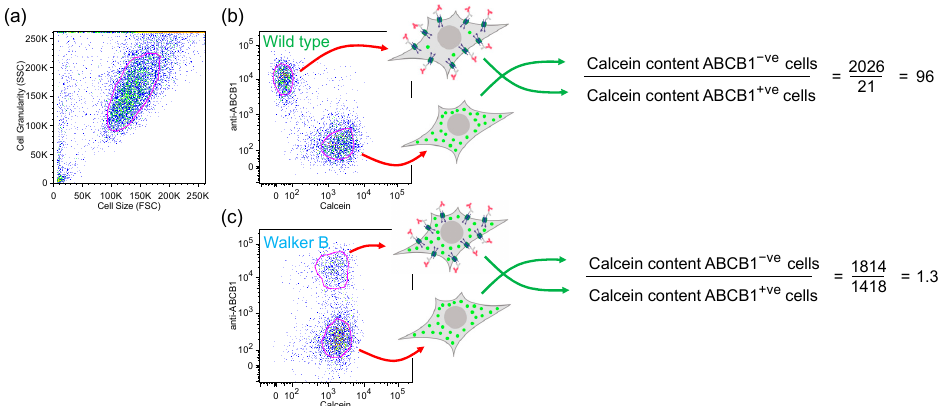
Figure 2. Measurement of functionality of ABCB1 for the transport of Calcein-AM by flow cytometry. ( a ) Dotplot showing the gating (autogated population circled in red) of HEK293T cells of normal size and granularity; ( b ) two-color dotplot of the gated normal cells showing green-fluorescent Calcein on the x-axis and red-fluorescent antibody binding on the y-axis. Cells that express wild-type ABCB1 bind the anti-ABCB1 antibody (red antibody shapes in the cartoon cell) and have a low level of accumulation of Calcein-AM (green circles in the cartoon cell) whilst untransfected cells accumulate high levels. The ratio of drug accumulation between the ABCB1-expressing and non-expressing cells is used to quantify transporter functionality. ( c ) Cells expressing the non-functional Walker B mutant (E556/1201Q) accumulate the same level of Calcein-AM as the untransfected cells in the